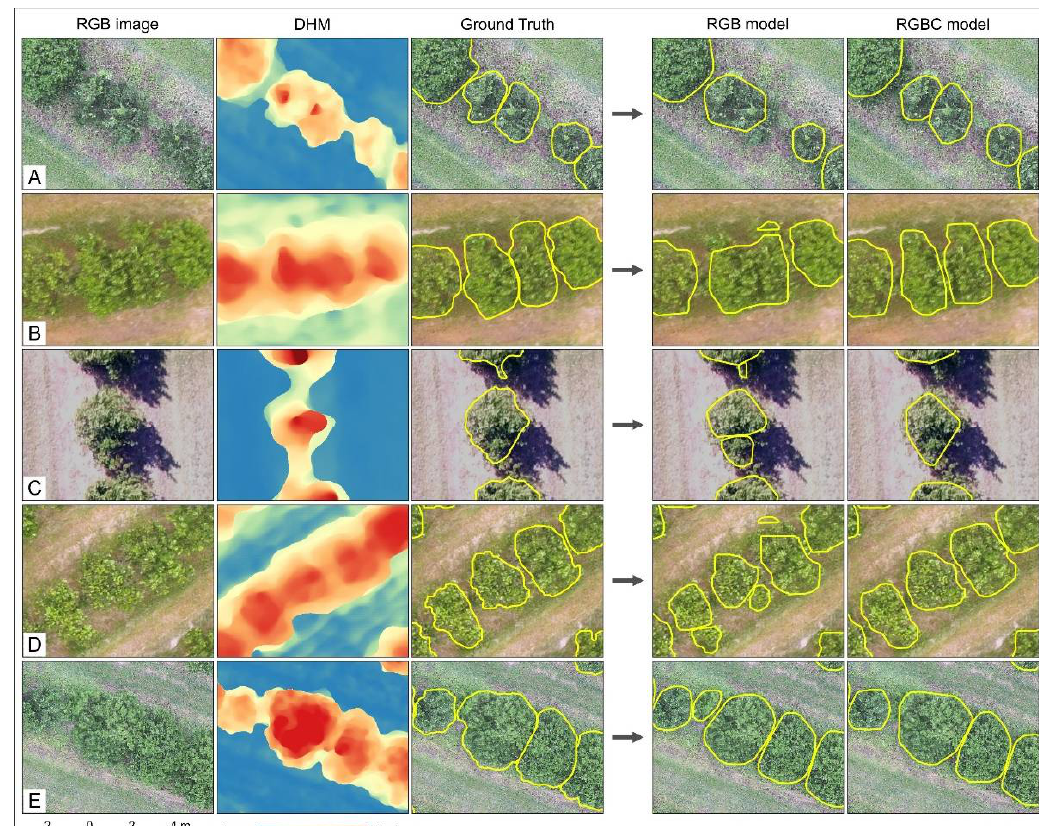
Figure 9. Results of canopy detection and delineation process. ( A – E ) indicate different canopy scenarios of orange plantation.